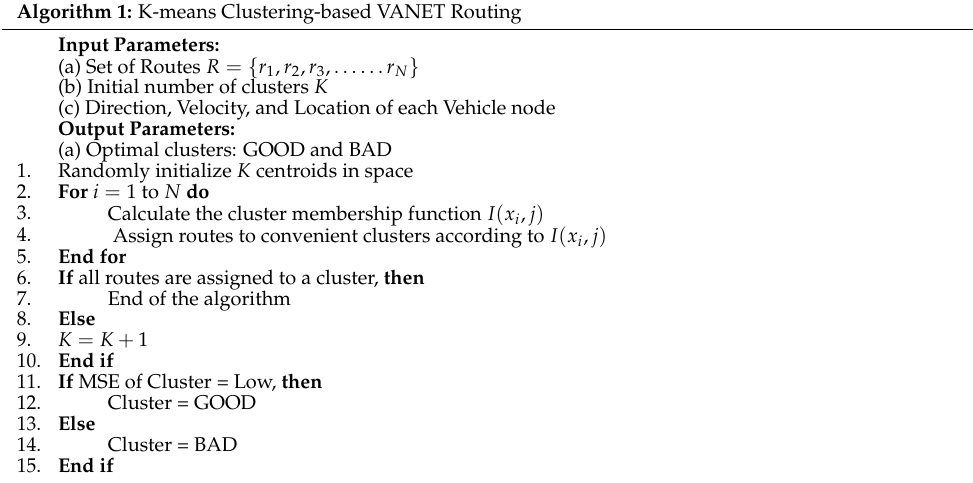
Algorithm 1: K-means Clustering-based VANET